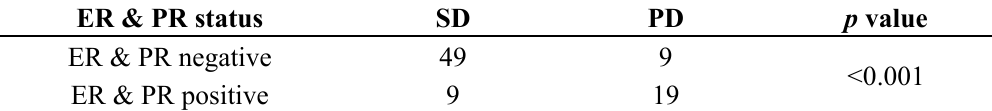
Table 7. Relationship between ER & PR expression and SD and